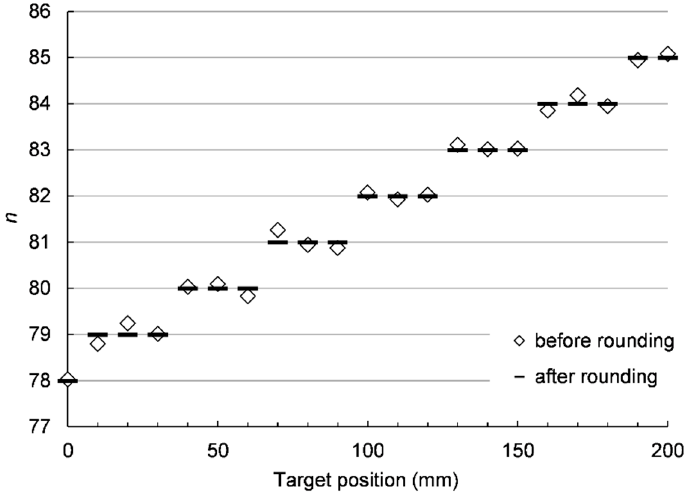
Figure 7. The values of n , before and after rounding.